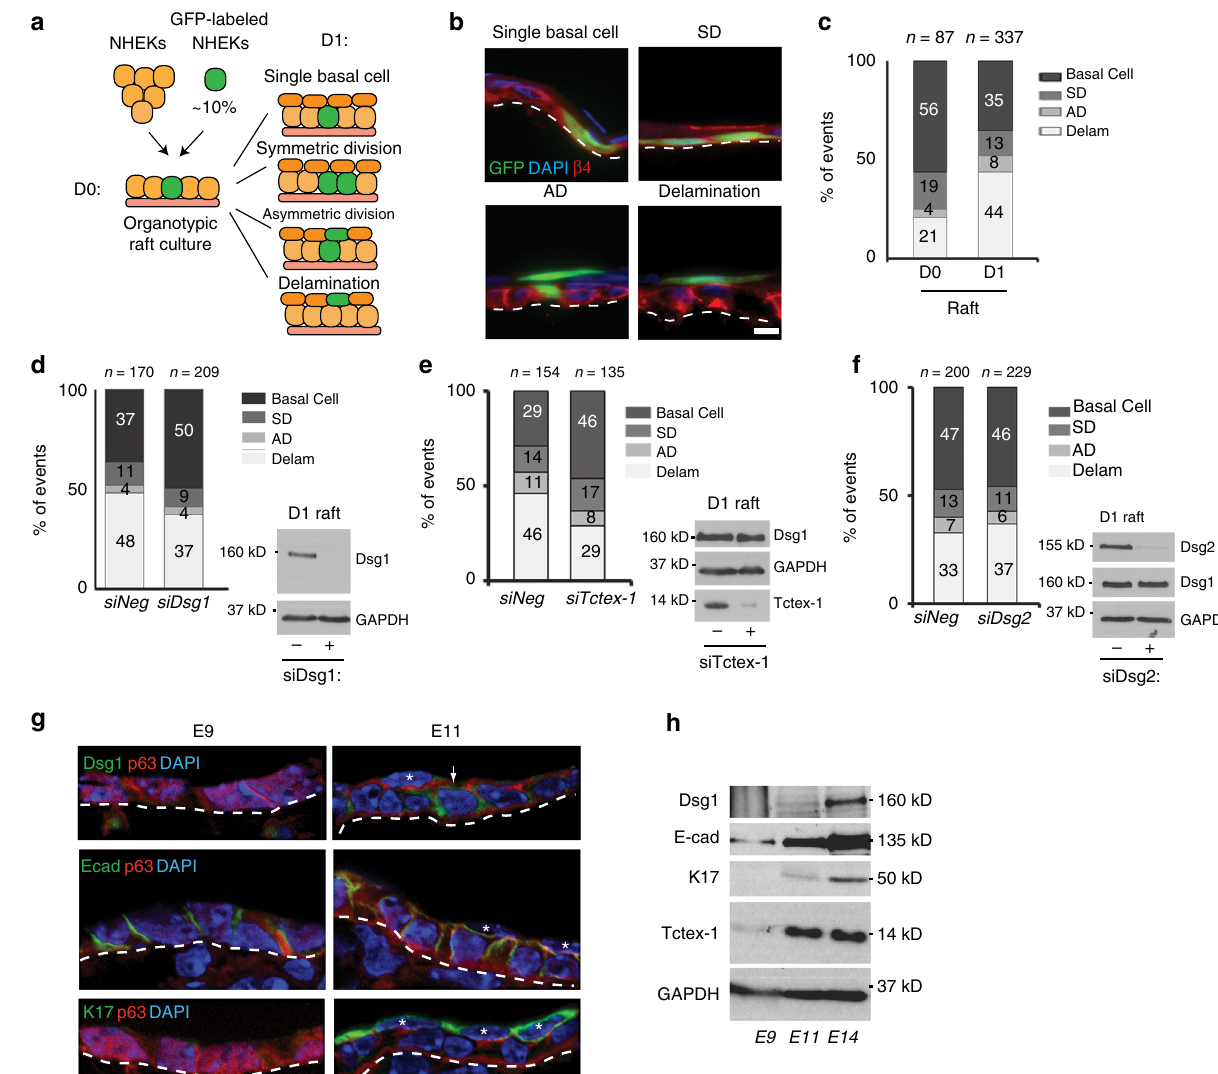
Fig. 8 Tctex-1 dependent Dsg1 localization at the cell – cell interface promotes keratinocyte delamination. a Diagram of experimental design for analyzing early strati fi cation events in 3D organotypic cultures (rafts) containing <10% GFP-positive cells. b The distribution of GFP-labeled cells used to track the events 24 h after initiation of strati fi cation. Examples of observed events are shown. β 4 integrin staining marks the basal layer, DAPI staining marks nuclei. c – f Bar graphs are population analyses showing the percentage of single basal cells (Basal Cell), symmetric division (SD), asymmetric division (AD) and delamination (Delam) observed in D0 (time of lifting to an air – liquid interface) and D1 rafts (one day after lifting to an air – liquid interface) ( c ), and D1 rafts treated with siNeg and siDsg1 ( d ), siTctex-1 ( e ), or siDsg2 ( f ) from at least fi ve independent experiments for each condition. n represents the total number of events scored. Delamination events were signi fi cantly increased in D1 rafts compared to D0 (*** p < 0.001, unpaired two-tailed t test). Knockdown of Dsg1 or Tctex-1 inhibit delamination (* p < 0.05 paired two-tailed t test), while Dsg2 knockdown did not have an effect. Immunoblots indicating levels of protein knockdown are shown to the right of each graph. g Representative fl uorescence images of murine epidermis at days E9 and E11. Tissues were stained for Dsg1, E-cadherin, Keratin 17 (K17) (periderm marker), and p63 (ectoderm marker). DAPI staining marks nuclei. Dsg1-positive cells (arrowhead) were commonly seen associated with strati fi ed periderm cells at E11 (asterisks). h Western blot analysis of Dsg1, E-cadherin, K17, and Tctex-1